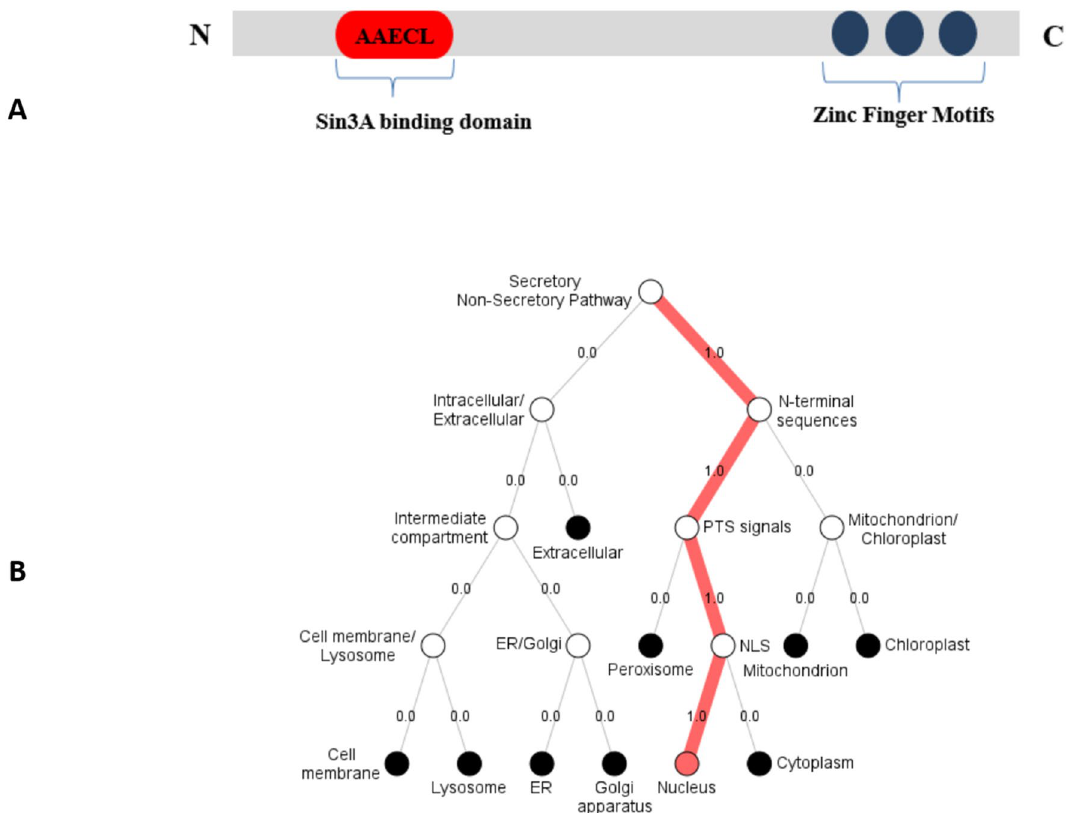
Figure 11. KLF14’s domains and cellular localization. ( A ) Primary structure of KLF14 showing the uniqueness of protein. Three zinc finger domains at C terminus and Sin3A binding domain at N terminus. ( B ) Localization of KLF14. DeepLOc 1.0 32 shows strong evidence of the presence of KLF14 inside